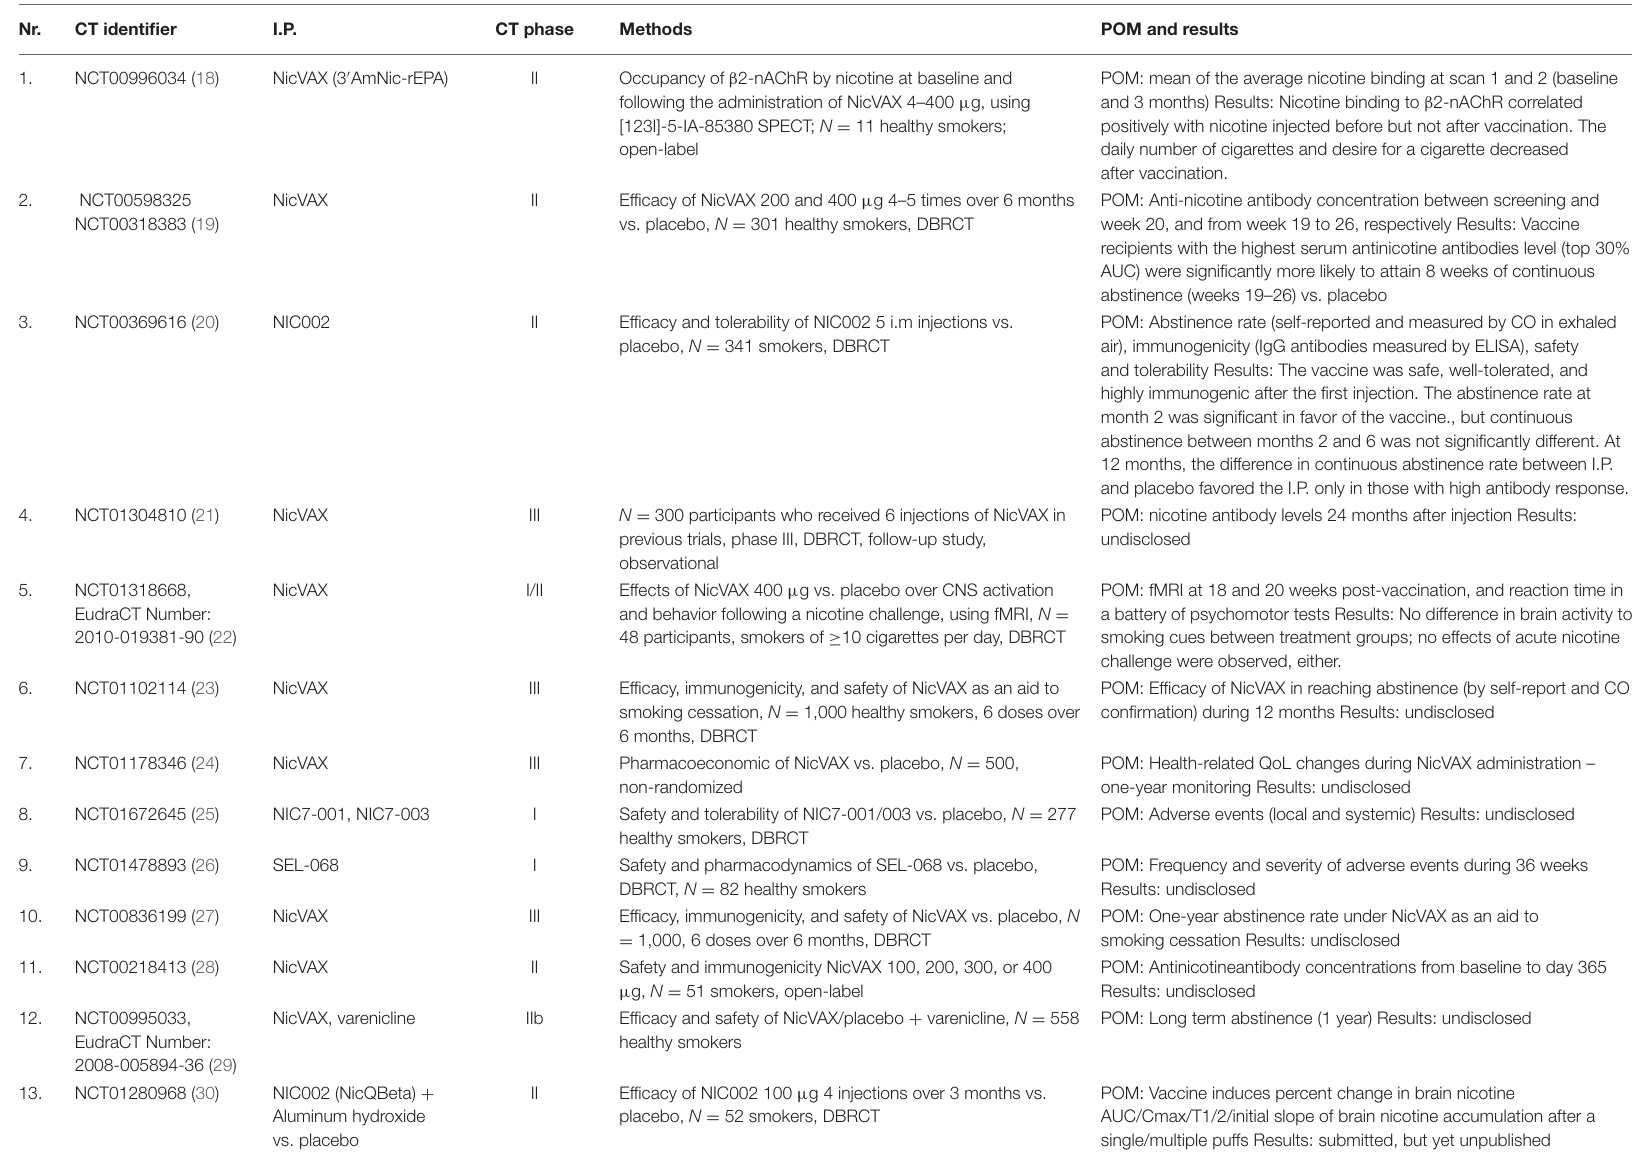
TABLE 1 | Active and passive immunization in